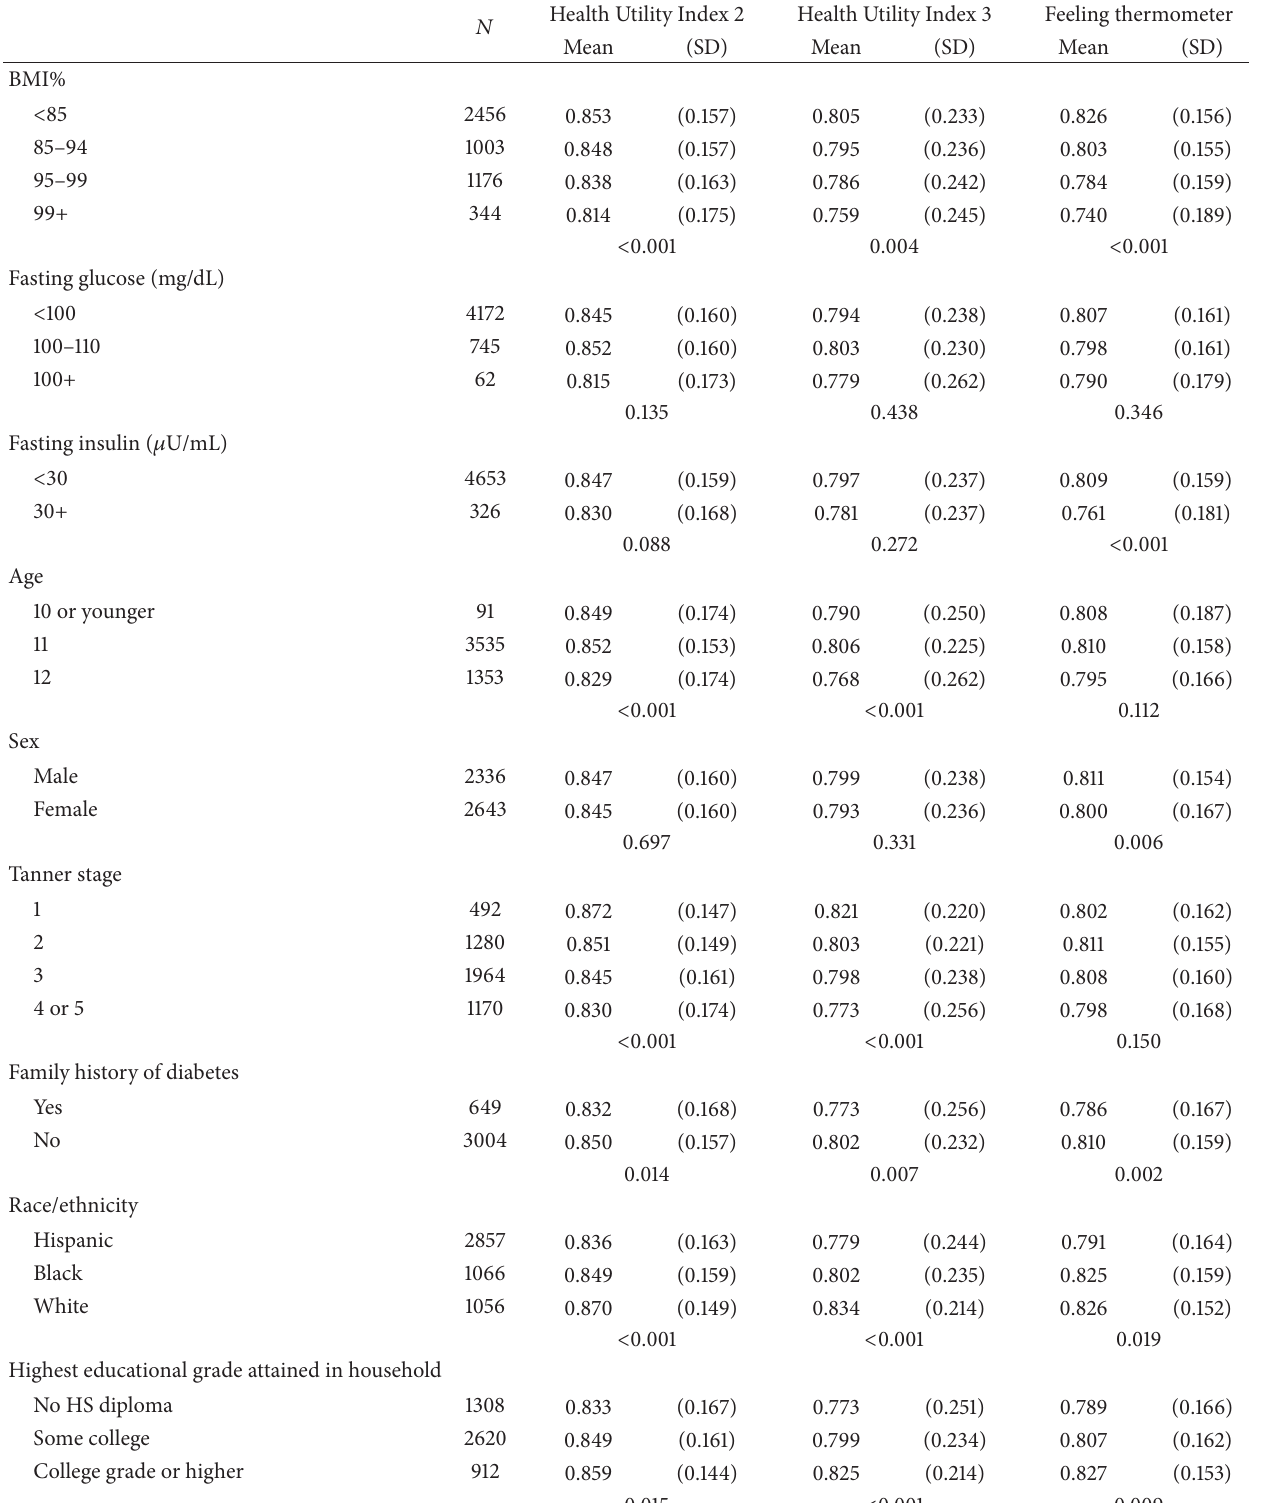
Table 2: Unadjusted preference-weighted QOL scores stratified by clinical and demographic